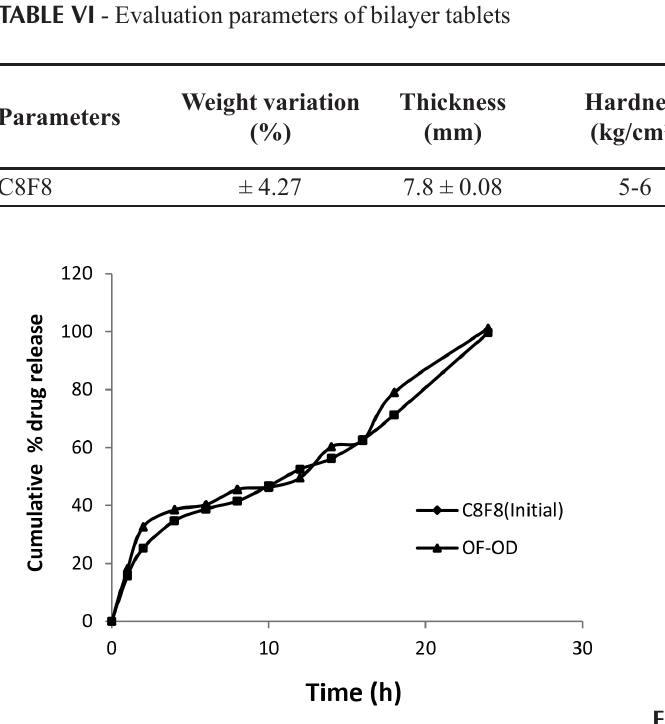
FIGURE 5 - Cumulative percentage of ofloxacin released versus time (hour) in pH 1.2 buffer for 2 hour, pH 4.5 acetate buffer for next hour and pH 7.4 phosphate buffer 900 ml at 100 rpm using USP type I dissolution test apparatus (mean ± SD, n= 6) for remaining hours. C8F8 (Initial), data of initial condition and OF-OD, marketed reference